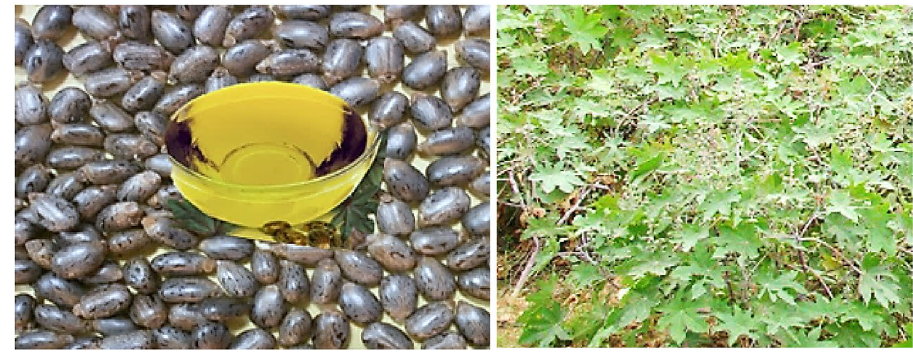
Figure 1. R. Communis Seed has taken from Oromia Region, East Wollega Zone Gudaya Bila,